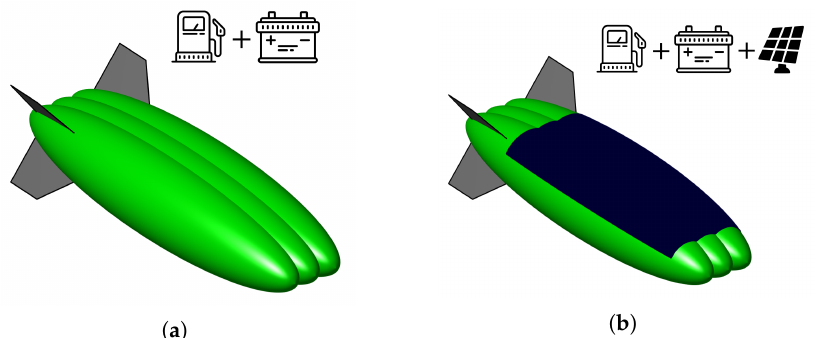
Figure 9. Airship powered by different sources of energy: ( a ) fuel and batteries and ( b ) fuel, batteries, and array.